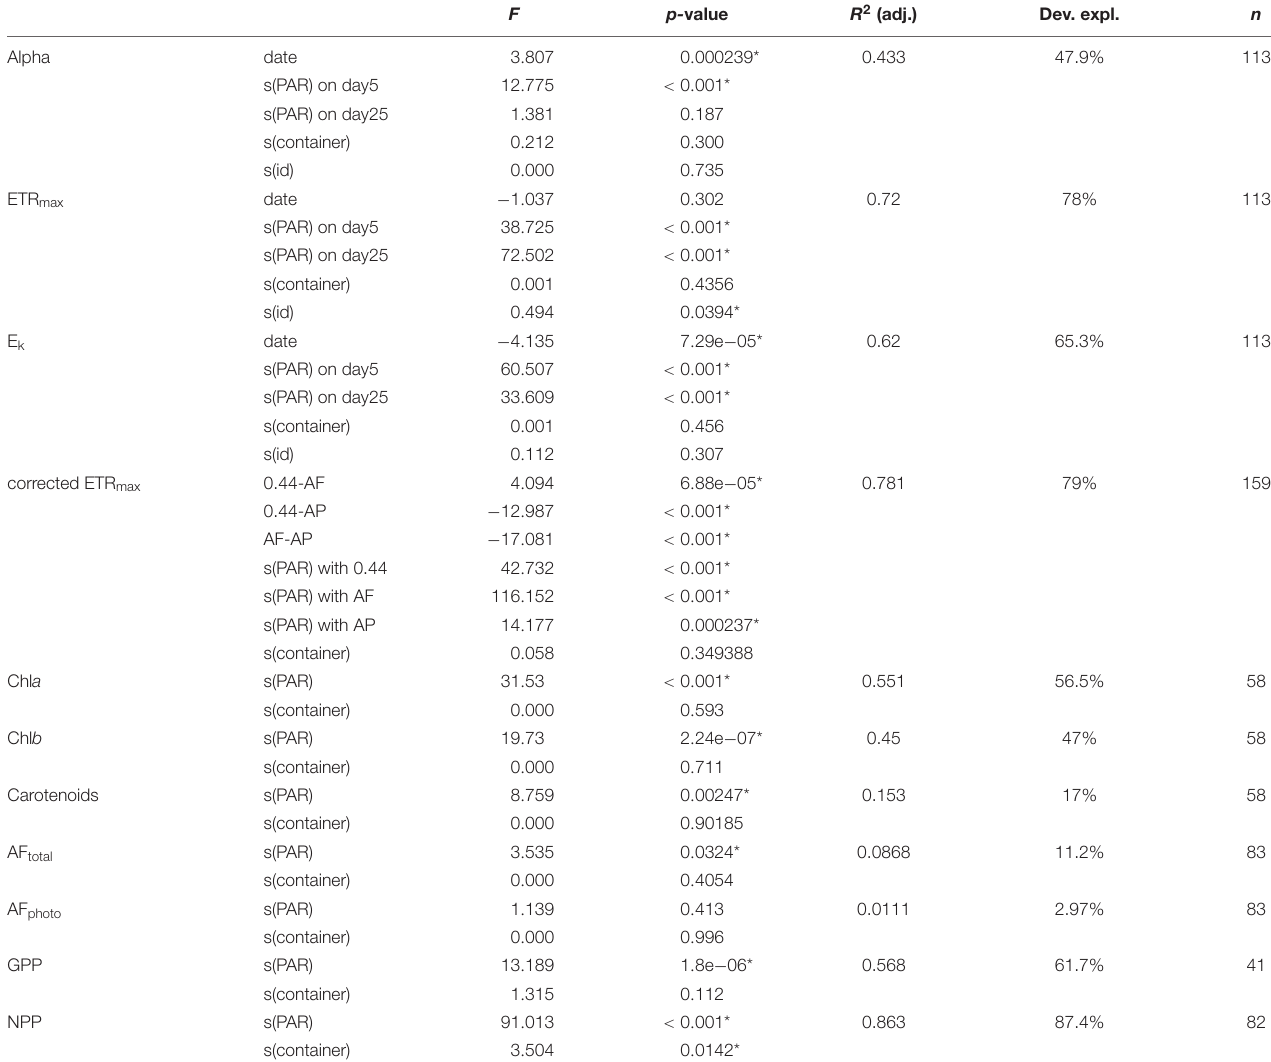
TABLE 1 | Output of the hierarchical generalized additive models (HGAM) analyses. F p- value R 2 (adj.) Dev.